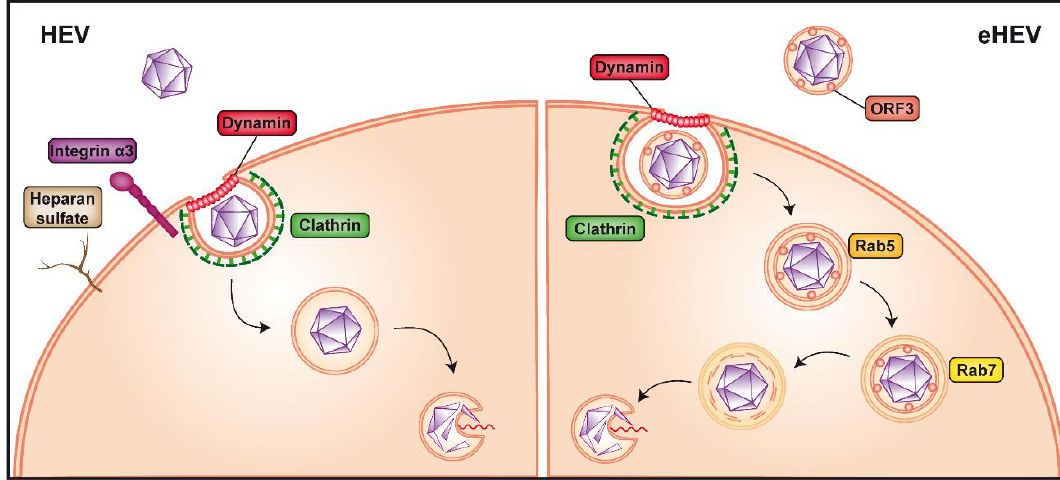
Figure 2. Non-enveloped versus quasi-enveloped hepatitis E virus entry. Non-enveloped hepatitis E virus (HEV) is believed to first bind to heparan sulfate proteoglycans and integrin α3 at the cell surface (left panel). The virus is then internalized via clathrin- and dynamin 2-dependent endocytosis, followed by release of the viral genome into the cytoplasm by an as yet unknown mechanism, possibly involving a conformational change of the capsid. The cofactor(s) and receptor(s) allowing entry of quasi-enveloped HEV (eHEV) are unknown (right panel). Internalization requires clathrin- and dynamin 2-dependent endocytosis as well as trafficking through Rab5- (early) as well as Rab7-positive (late) endosomes and eventually lysosomes to allow release of the viral genome into the cytoplasm, likely by a process similar to that of naked HEV.